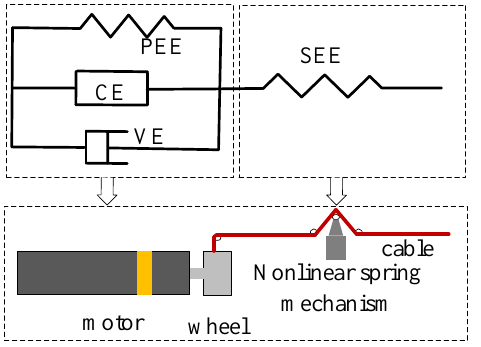
Figure 3. Equivalent nonlinear series elastic mechanism of muscle.